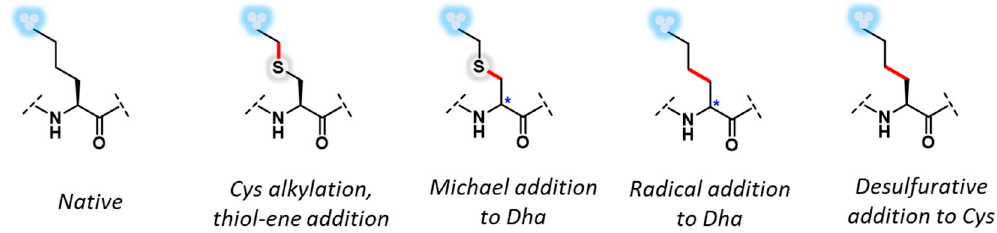
Figure 5. Synthetic strategies for site-selective installation of PTMs.